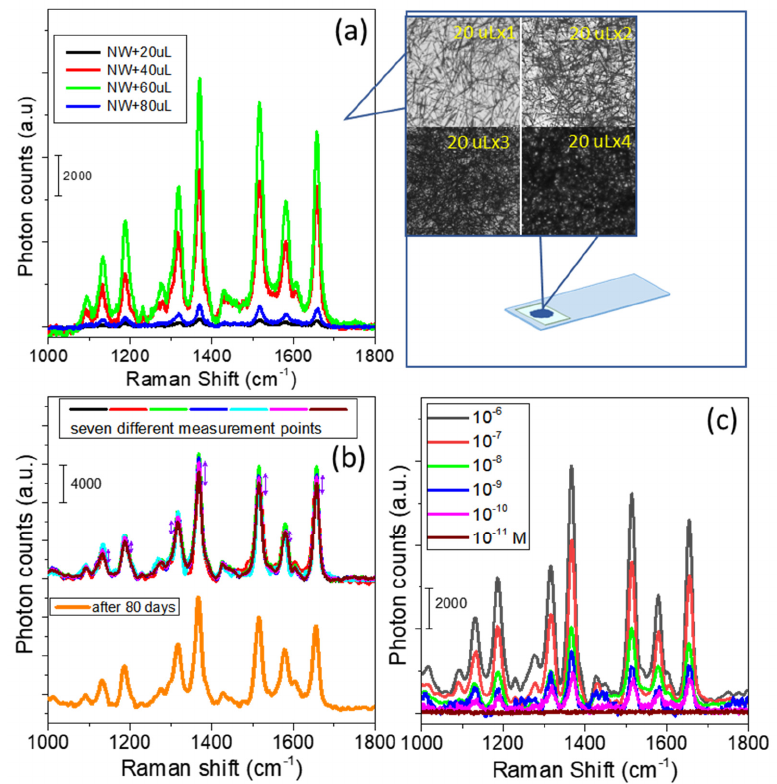
Figure 3. ( a ) 20 μ L of 10 μ M R6G sprinkled onto glass was coated with variable densities of Ag NWs (20 μ L × 1, 2, 3, 4, 5). ( b ) SERS collection at seven different locations on a freshly prepared 3D-RCW chip (top); these signals dropped by